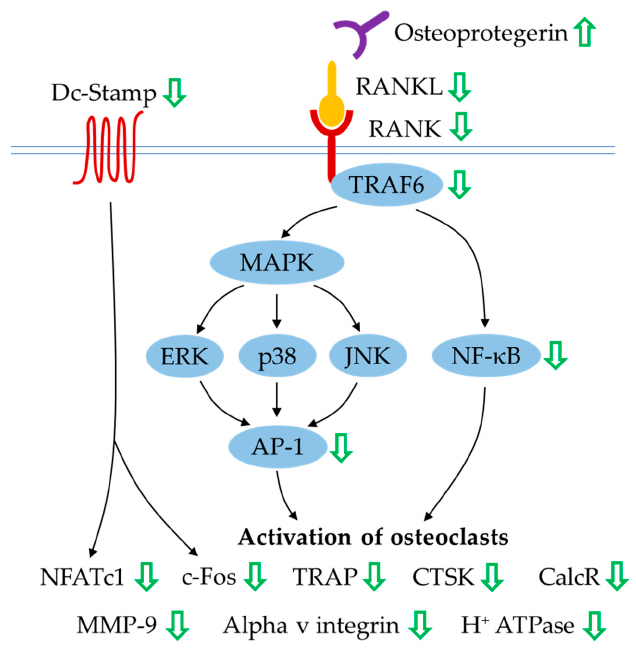
Figure 1. The effects of quercetin on the RANK/RANKL/osteoprotegerin system in regulating osteoclastogenesis. Quercetin causes differential expression of osteoprotegerin and RANKL by osteoblasts. In osteoclasts, quercetin reduces the expression of osteoclast-related markers governed by inhibition of NF- κ B and AP-1 activation (indicated by the green arrows); thus, the maintenance of osteoclast lineage commitment, osteoclast maturation and bone resorption are inhibited. Abbreviation: AP-1 = activator protein-1; CalcR = calcitonin receptor; c-Fos = cellular proto-oncogene;